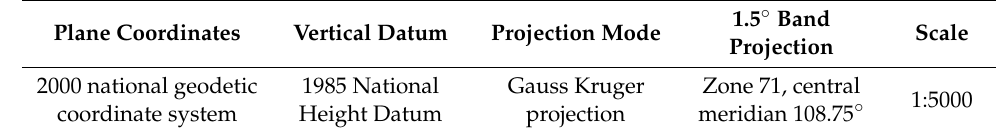
Table 3. Multibeam bathymetric datum.